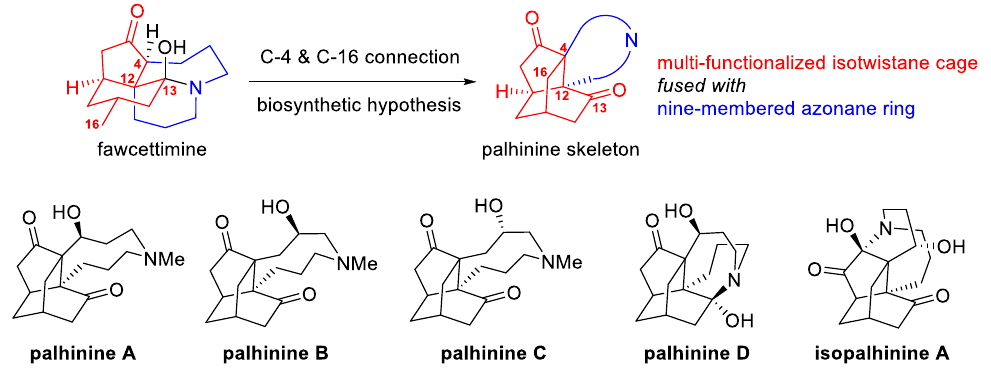
Figure 1. Five palhinine family Lycopodium alkaloids.